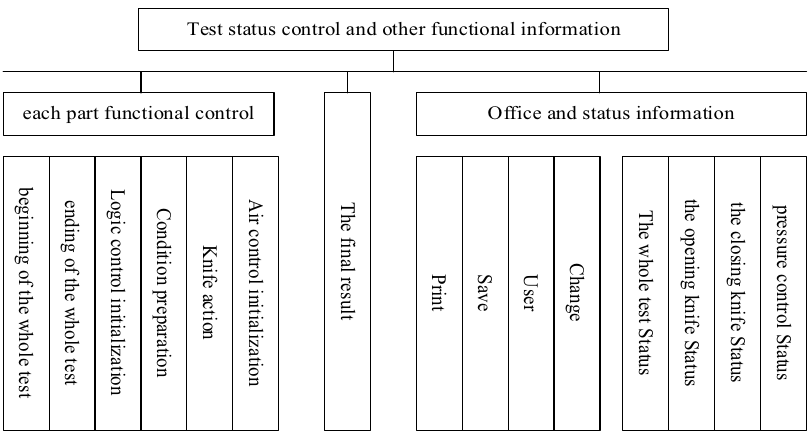
Fig. 4. Test state control